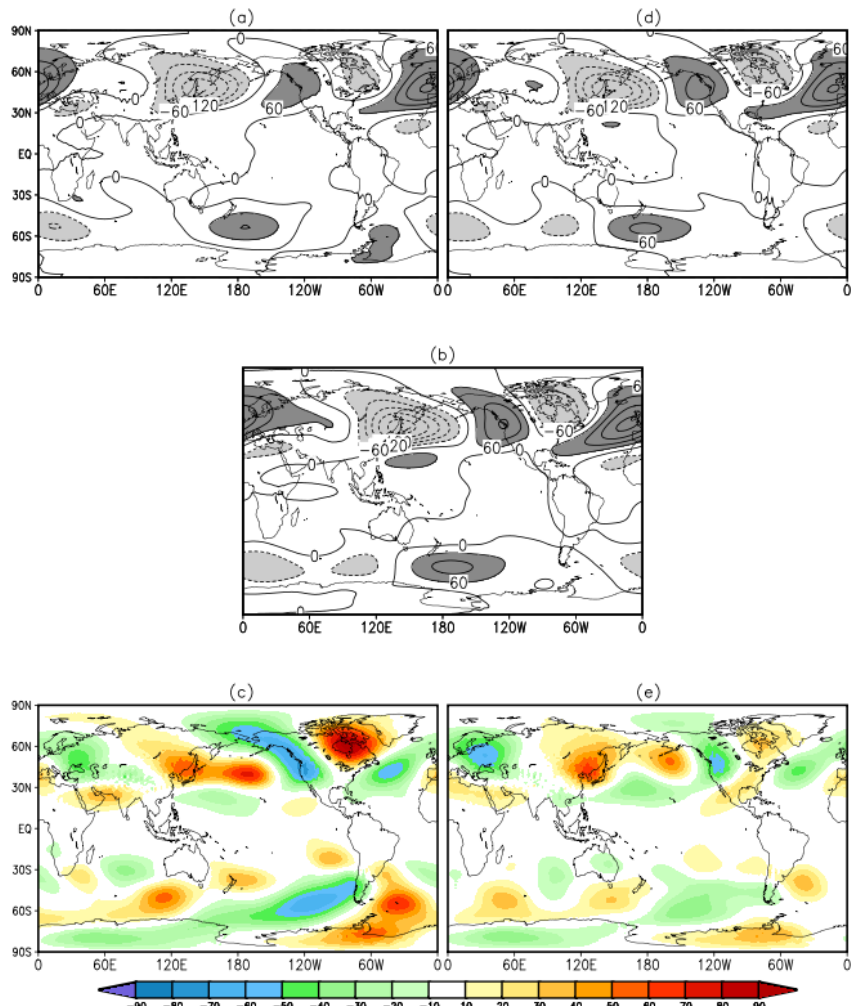
Figure 13. December-January-February 300mb eddy height climatology in meters from (a) experiment 6 (MERRA AGCM-like), (b) MERRA, (c) the difference of experiment 6 minus MERRA, (d) experiment 5 (MERRA2 AGCM-like), (e) the difference of experiment 5 minus